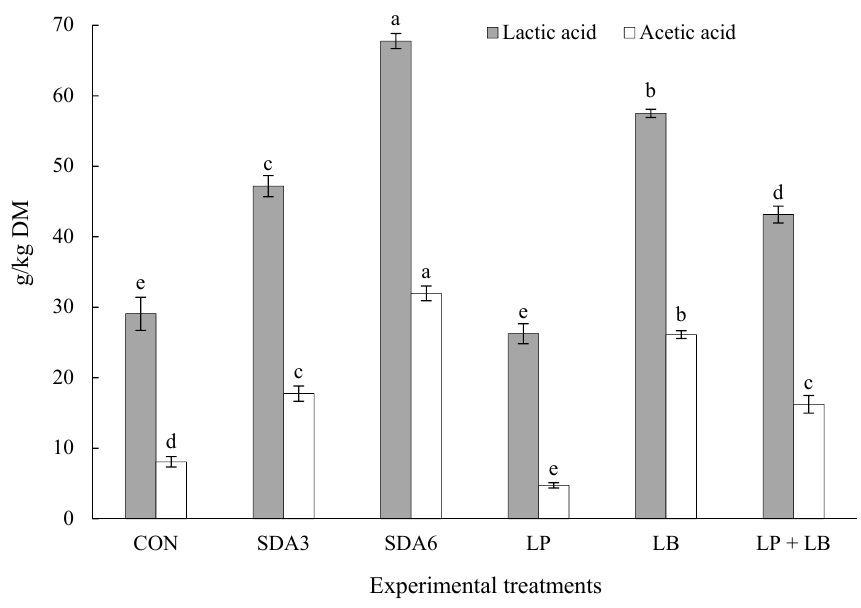
Figure 5. Lactic acid and acetic acid concentration in early-harvested rye ensiled for 60 d with different additives after aerobic exposure. Experi - mental silages were untreated silage (CON); SDA3 = sodium diacetate at 3 g/kg fresh weight; SDA6 = sodium diacetate at 6 g/kg fresh weight; LP = L. plantarum ; LB = L. buchneri ; LP+LB = L. plantarum + L. buchneri (equal proportion). Inoculant application rate was 1,000,000 cfu/g fresh weight. a-e Within the same microbes, means (±standard deviation) with unlike superscripts differ (based on Duncan’s test; p<0.05).